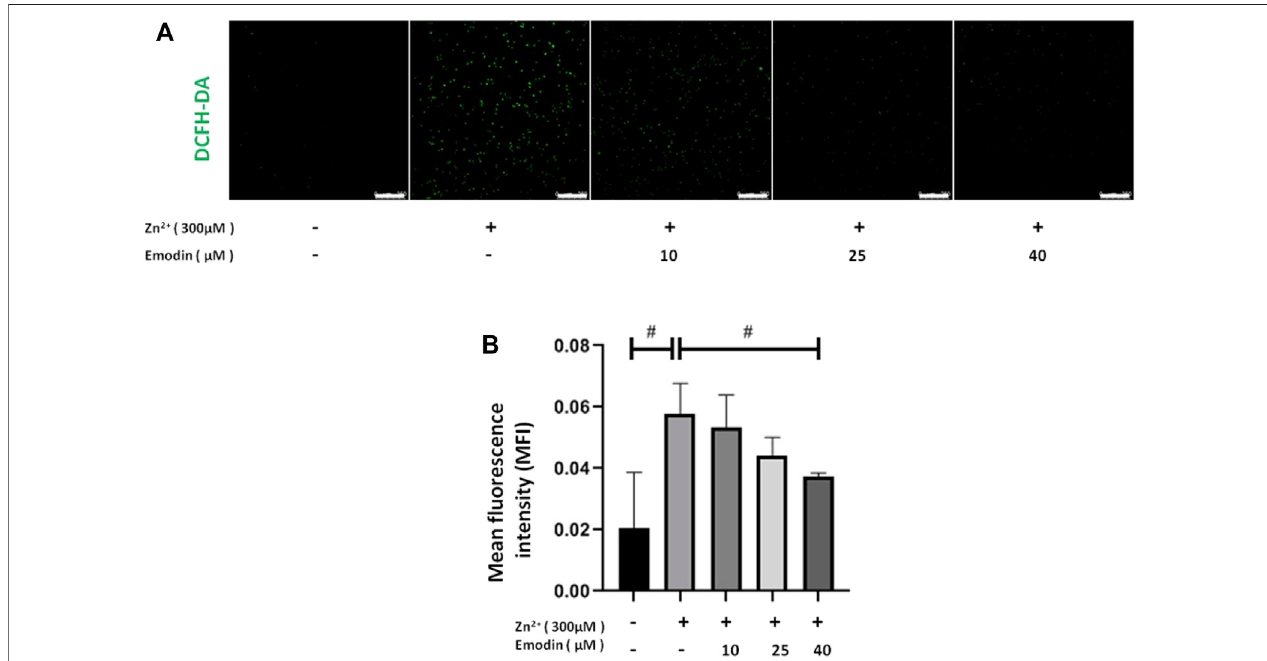
FIGURE2| Emodindecreasedzinc-inducedreactiveoxygenspeciesproductioninSH-SY5Ycells. (A) FluorescencestainingofDCFH-DAinSH-SY5Ycells.From left to right are untreated cells and 300 μ M zinc sulfate-treated cells without emodin pretreatment (10, 25, and 40 μ M). Scale bar = 250 μ m. (B) Mean fl uorescence intensity analysis. One-way ANOVA and Bonferroni post hoc analysis, # p < 0.05; Data are presented as the mean ± SEM.